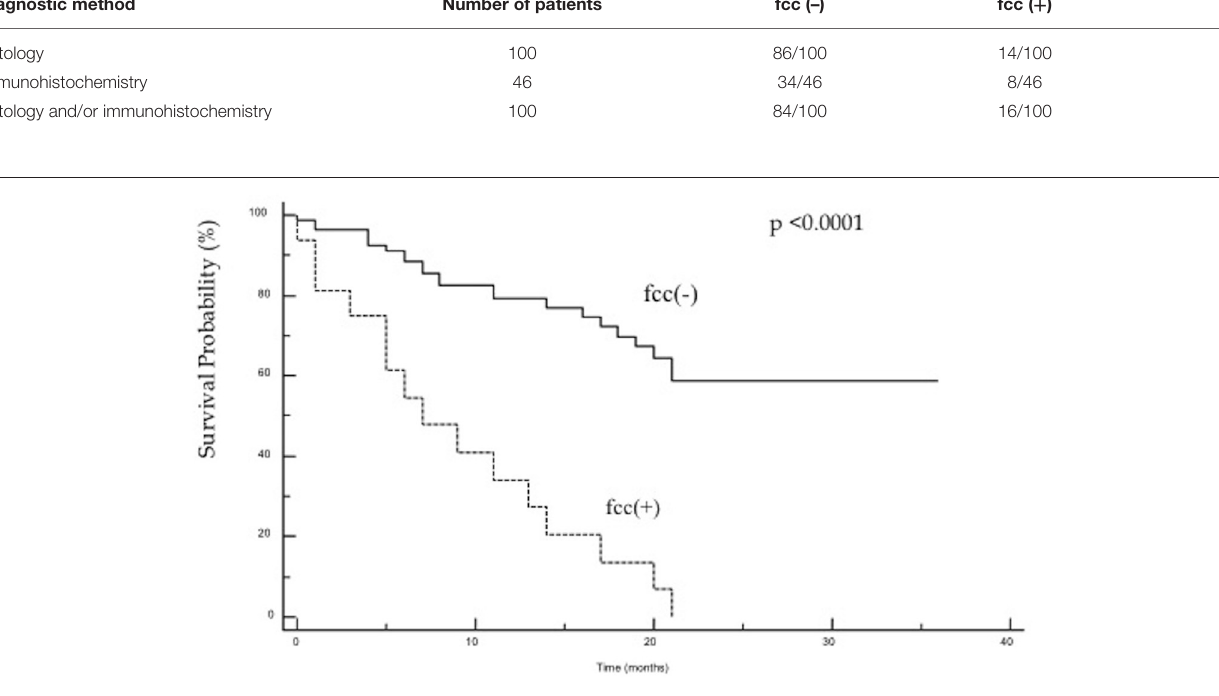
FIGURE 1 | A Kaplan–Meier survival curve for the entire study group, comparing patients with fcc ( + ) [hazard ratios (HR) 5.161 (95% CI: 1.884–14.135)] and fcc (–) [HR.193 (95% CI: 0.070–0.530), p <